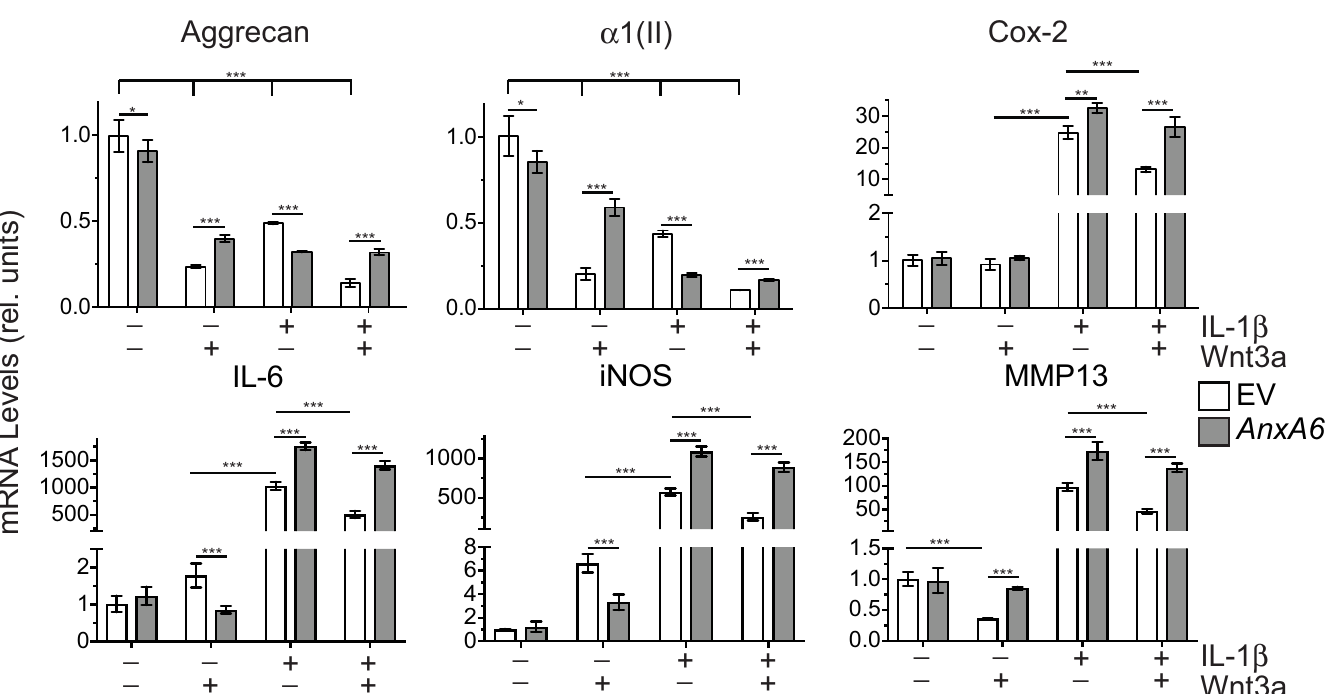
Fig 4. mRNA levels for articular cartilage markers (aggrecan, type II collagen ( α 1(II))and catabolic markers (Cox-2, IL-6, iNOS, MMP-13) in vehicle-treated, Wnt3a-treated, IL-1ß-treated, or combined Wnt3a- and IL-1ß-treated human articular chondrocytes overexpressing AnxA6. Human articular chondrocytes were transfected with empty expression vector (EV) or expression vector containing full-length AnxA6 ( AnxA6 ). Twelve hours after transfection cells were serum-starved for 24 h followed by treatment with IL-1ß, Wnt3a, IL-1ß, or combined IL-1ß and Wnt3a for 24h. Levels of mRNA were determined by real-time PCR using SYBR Green and normalized to the level of 18S RNA. The mRNA levels are expressed relative to the level of vehicle-treated cells transfected with empty expression vector, which was set as 1. Data were obtained from triplicate PCRs using RNA from 3 different cultures ( n = 3). Values are the mean ± SD. ( (cid:3)(cid:3) p < 0.01; (cid:3)(cid:3)(cid:3) p < 0.001).